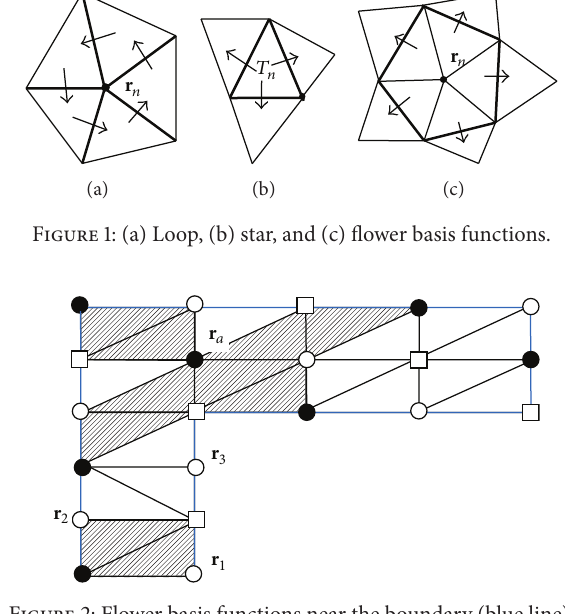
Figure 2: Flower basis functions near the boundary (blue